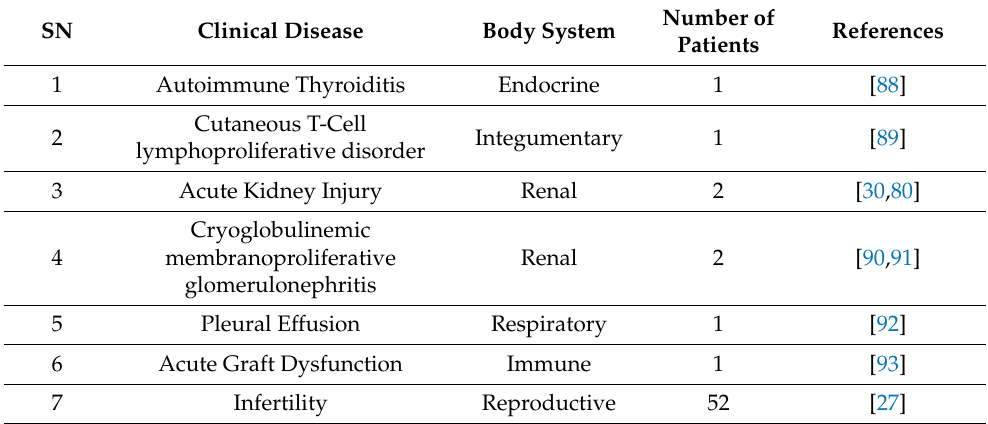
Table 4. Other body systems disorders related to HEV infection.